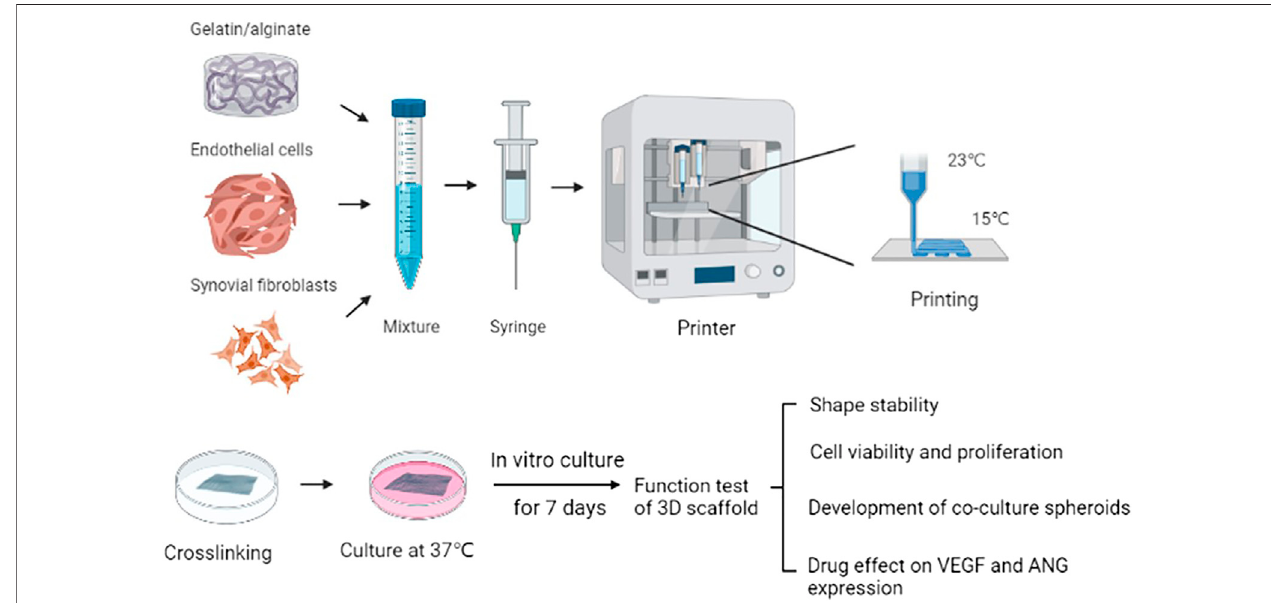
FIGURE 1 | Schematic of the 3D scaffold printing process. Fabrication of pannus mimic with gelatin /alginate and EA.hy 926/MH7A cells.